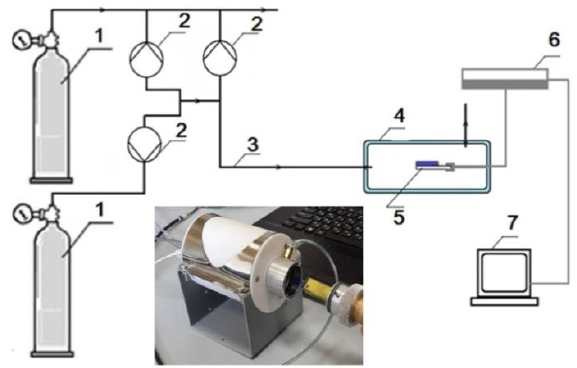
Figure 2. Scheme of the system for investigation of chemiresistive sensor response with a photograph of a gas flow cell: 1—tanks with a gaseous analyte and purging/diluent gas, 2—mass flow controllers, 3—gas mixture with a given analyte concentration, 4—gas flow cell, 5—active layer, 6—electrometer, 7—computer.